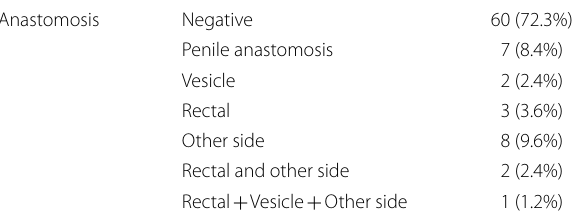
Table 3 Percentage of anastomosis between prostatic artery